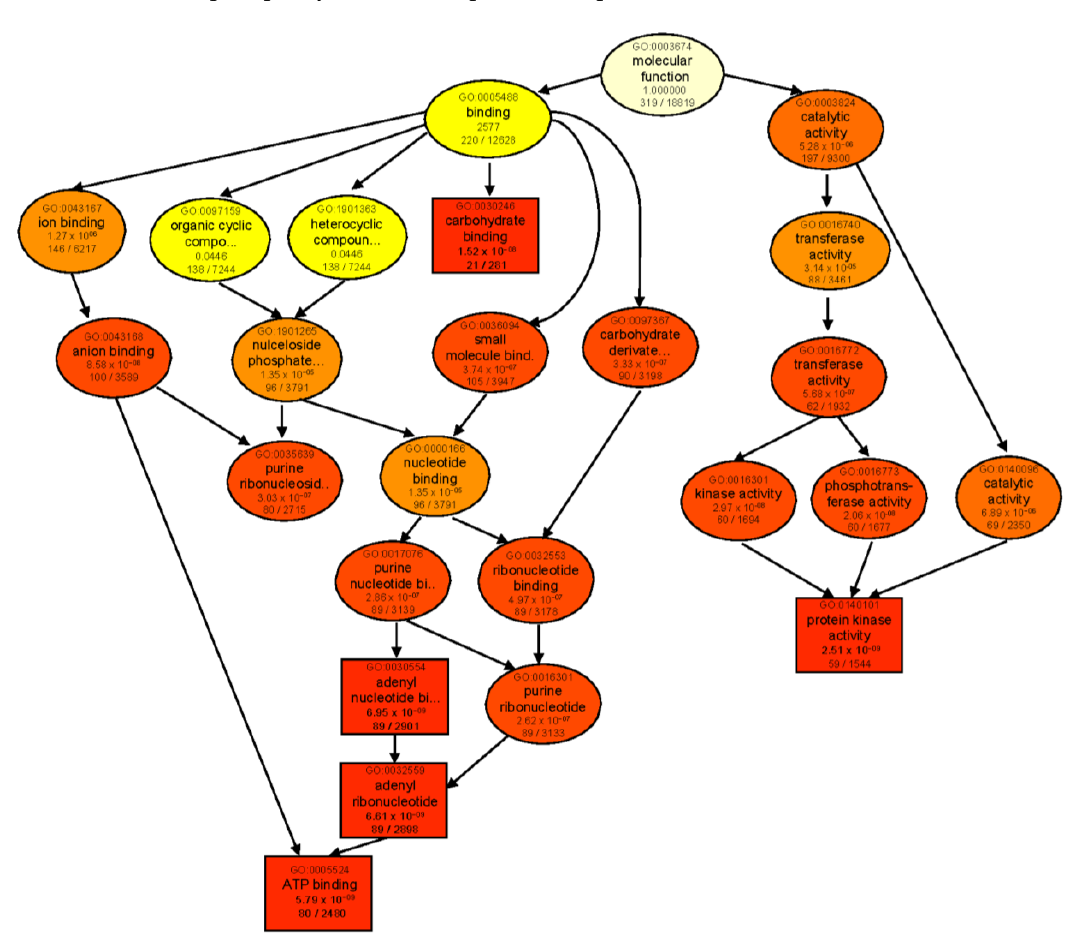
Figure 5. GO enrichment analysis of DEGs of the contrast group T 24 vs. B 24. Rectangles/circles contain the GO term number and category name. The numerals at the bottom in each box are the p-value followed by the number of genes in the input list that overlapped with a given GO term over the total number of genes in the GO term. The colors indicate levels of statistical significance, with darker colors indicating a more significant level of enrichment. The rectangles indicate top five enriched terms.